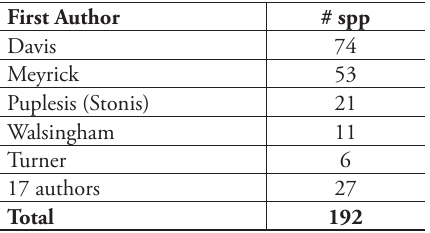
Table 3. Number of Opostegidae species (valid and invalid) described per first author for authors who described at least six valid